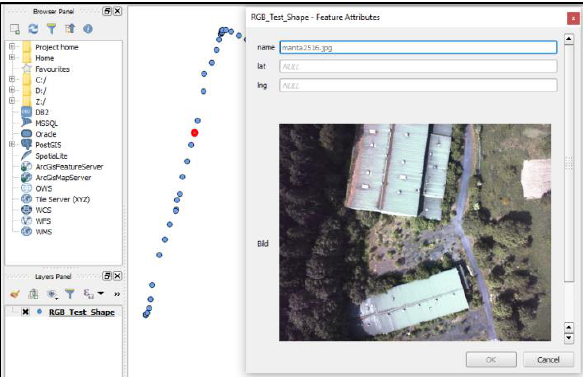
Figure 15: QGIS-Postgres/PostGIS connection (left), main image points as shape layer (middle) and an image viewer with its metadata like image name, latitude, longitude, etc.